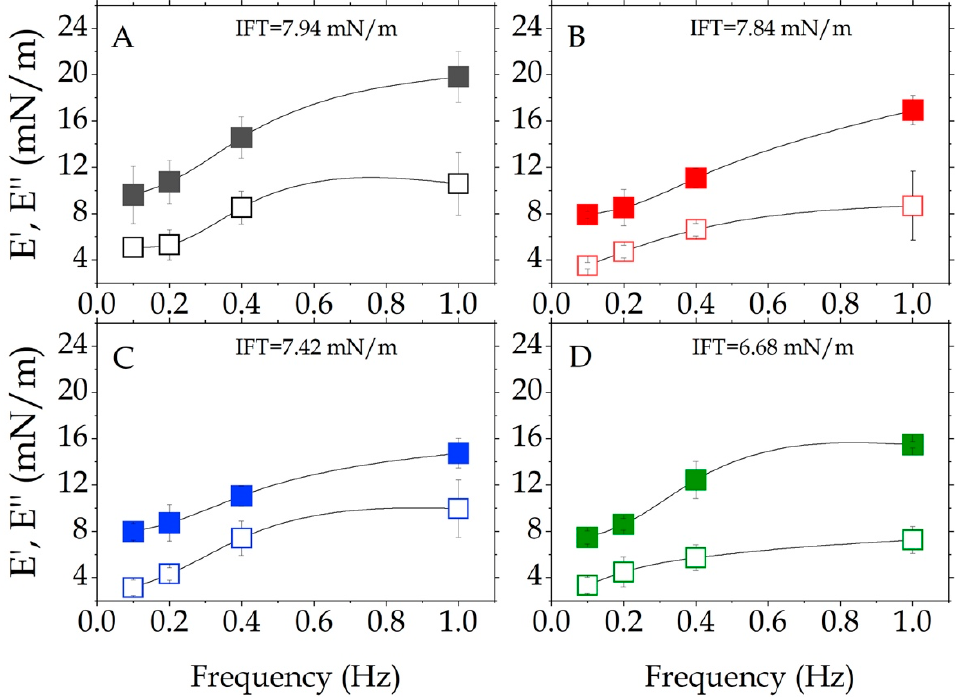
Figure 8. Interfacial viscoelastic properties of SPPH at room temperature (20 ± 0.01 °C) with 0 M ( A ), 0.1 M ( B ), 0.2 M ( C ) and 0.4 M ( D ) NaCl. Storage modulus (E ′ ) represented with closed symbols and loss modulus (E ″ ) with open symbols. Final Interfacial Tension Values (IFT) are also presented for each sample. Dash line is guide to the eye.